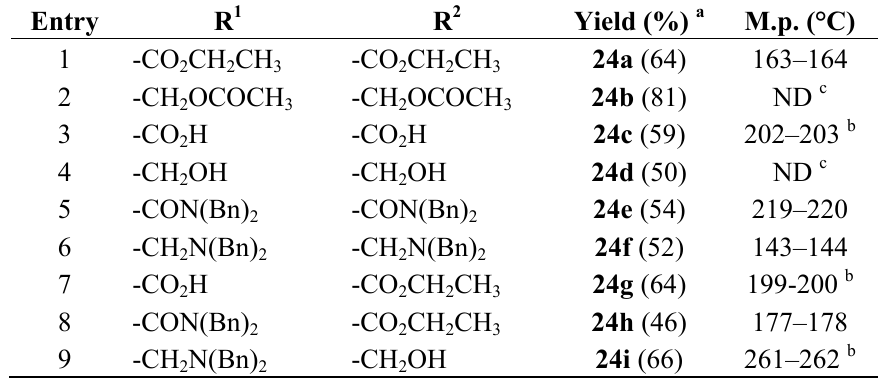
Table 1. Experimental yields of the tosyl hydrazone derivatives 24a–i as shown in Scheme